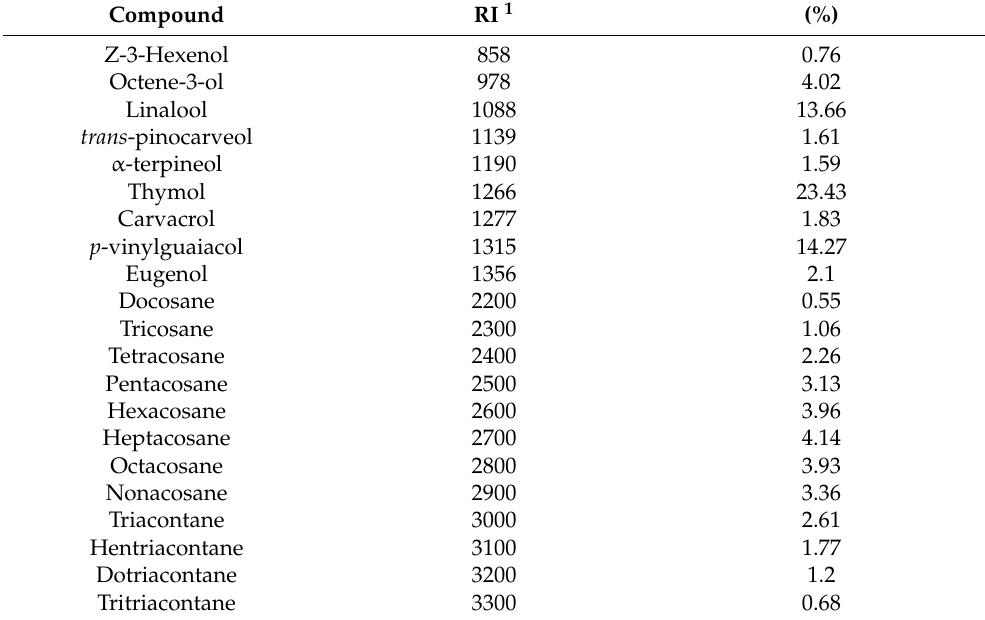
Table 4. Essential oil composition (% total peak area) of A. iva leaves ( n = 3 samples, 3 replicates per